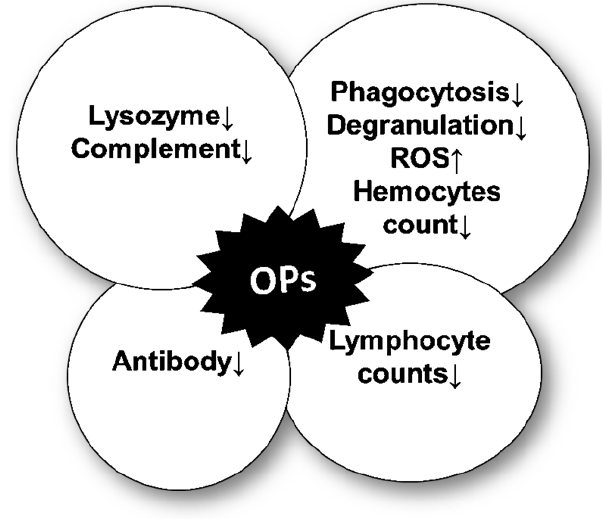
Figure 1. Main alterations of humoral and cellular mechanisms of innate and adaptive immunity mediated by OP exposure (Increase ↑ , decrease ↓ ).